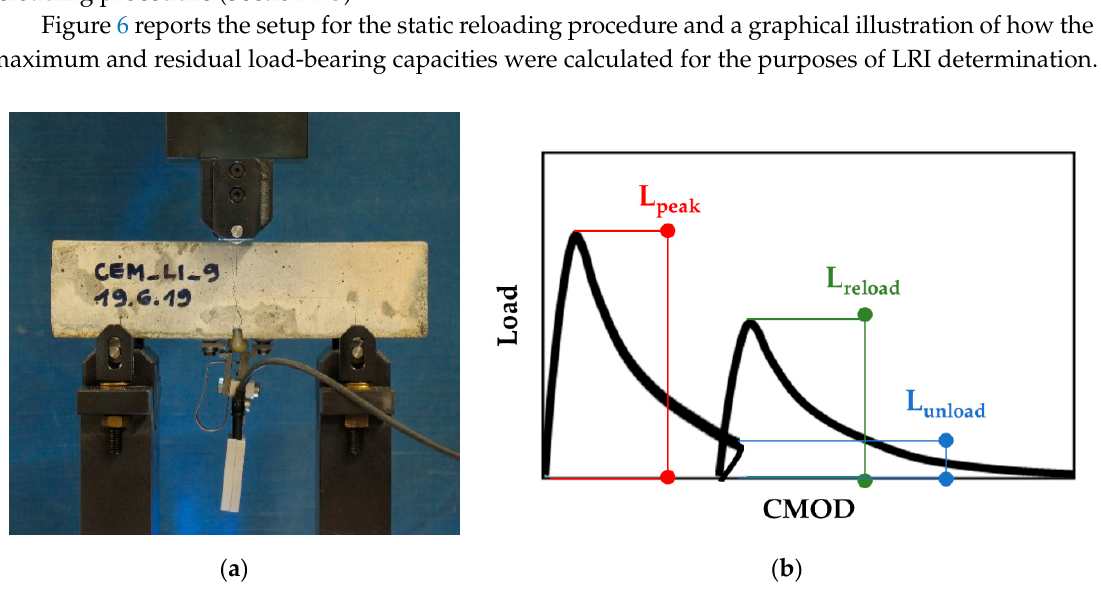
Figure 6. ( a ) Experimental setup for the static reloading procedure; ( b ) schematic load versus crack mouth opening displacement (CMOD) curves related to pre-cracking and reloading, with indication of maximum and residual load-bearing capacities. 2.5. Cyclic Reloading After the static reloading of half of the pre-cracked specimens (Section 2.4), the mechanical behaviour under cyclic flexural loading was evaluated. In order to investigate the behaviour in cyclic conditions, the remaining specimens were reloaded through a force-controlled three-point bending test with the same span used for the pre- cracking and static reloading (10 cm) and using the same closed-loop servo-controlled hydraulic press. In order to measure the damage evolution during the cyclic loading in terms of increment of crack opening displacement (COD), an inductive displacement transducer (WI, range 0–5 mm, HBM, Germany), connected to the digital controller through a measuring amplifier (SCOUT55, HBM, Germany), was mounted on the lateral surface of the tested specimen, just above the tip of the notch. It was not possible to mount the WI displacement transducer on the bottom face to measure the CMOD as in the pre-cracking and reloading setup because of the lack of space between the supports. The force controlled three-point bending test was conducted by first reloading the specimens up to a maximum load value L max with a load rate of 50 N/s. Upon reaching L max , a sinusoidal loading with a frequency of 4 Hz was applied, where the peaks were set to L max and the valleys to a lower load value L min . Figure 7 reports the experimental setup and a graphical illustration of the loading procedure used for the cyclic reloading.